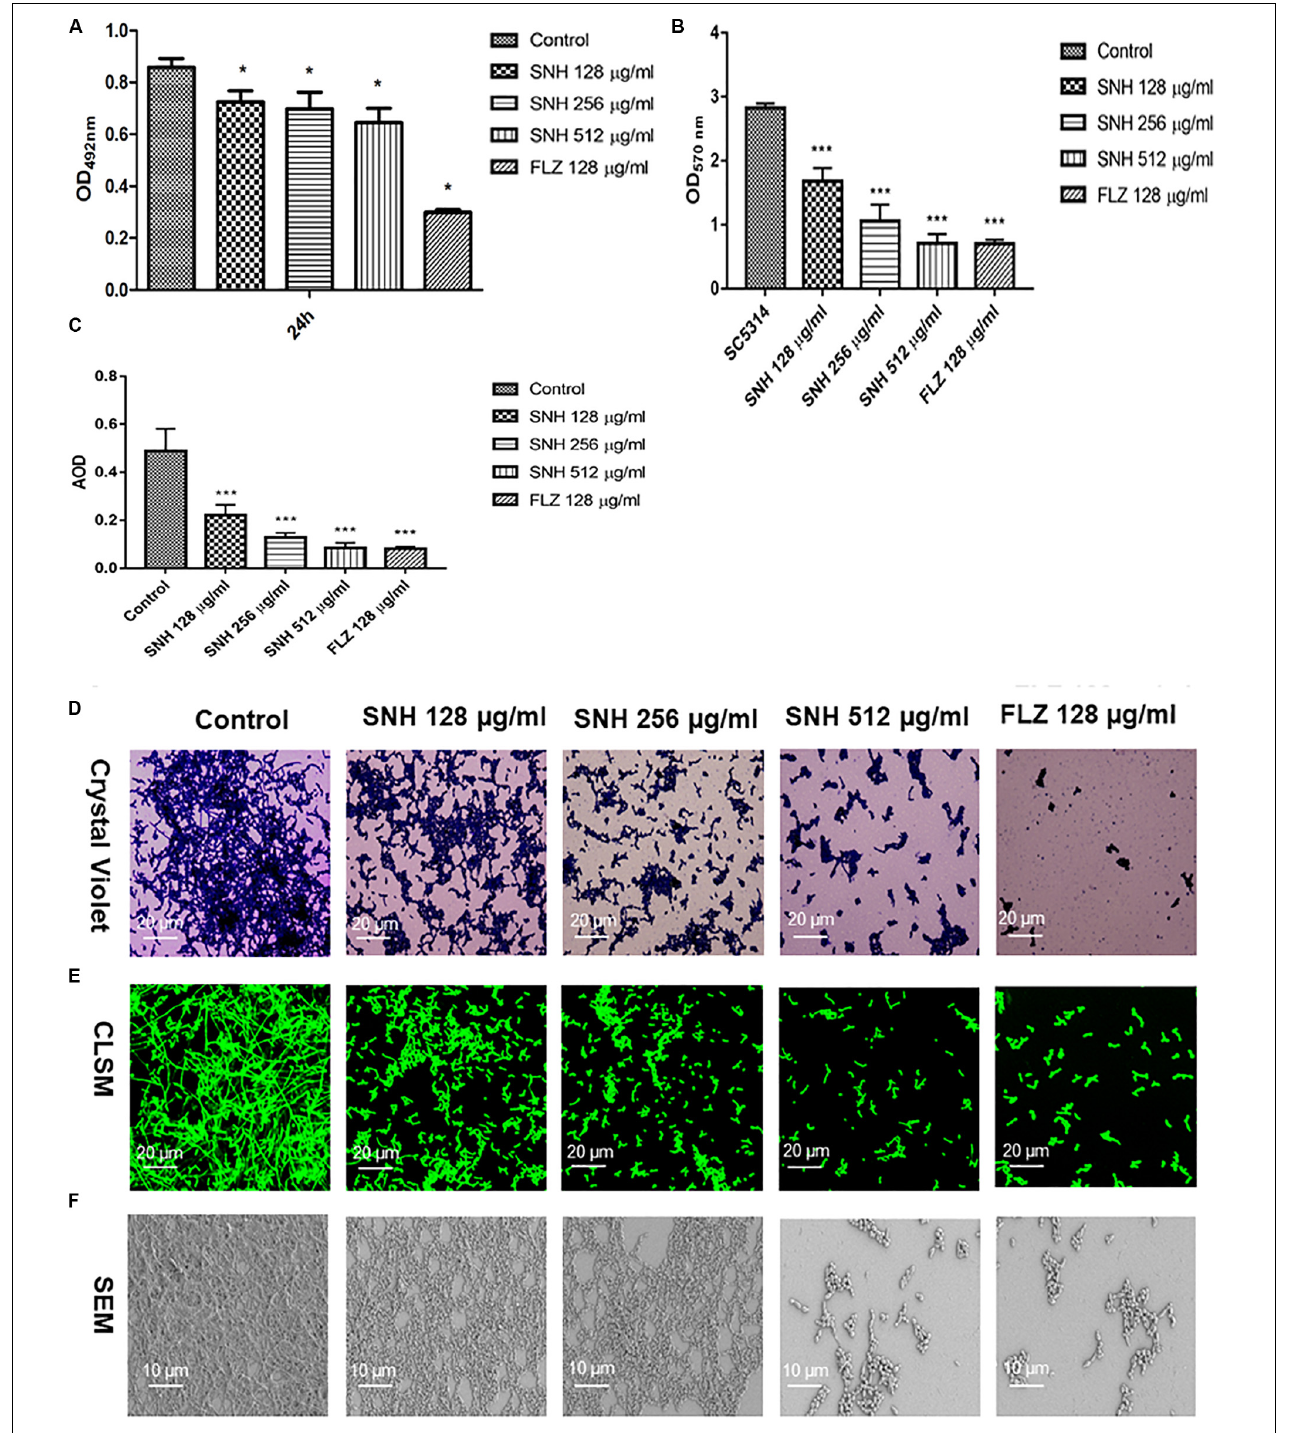
FIGURE 2 | (A) Effect of SNH on biofilm metabolic activity in C. albicans SC5314 by the XTT reduction assay. The drug-free strain-containing medium was set as the control. Data are shown as mean ± SD. * p < 0.05, compared with the control. (B) Quantitative determination of C. albicans SC5314 biofilm by crystal violet. The drug-free strain-containing medium was set as the control. Data are shown as mean ± SD. *** p < 0.001, compared with the control. (C) Analyze the AOD (AOD) of CLSM fluorescent C. albicans SC5314 biofilm by Image J. The drug-free strain-containing medium was set as the control. Data are shown as mean ± SD. *** p < 0.001, compared with the control. (D) Crystal Violet Staining of C. albicans SC5314 biofilm by optical microscope ( × 400). (E) Observation of morphological changes of C. albicans SC5314 biofilm by CLSM ( × 400). (F) Observation of morphological changes of C. albicans SC5314 biofilm by SEM ( × 500). The initial inoculum was newly prepared at 2 × 10 6 CFU/mL. The drug-free strain-containing medium was set as the control.